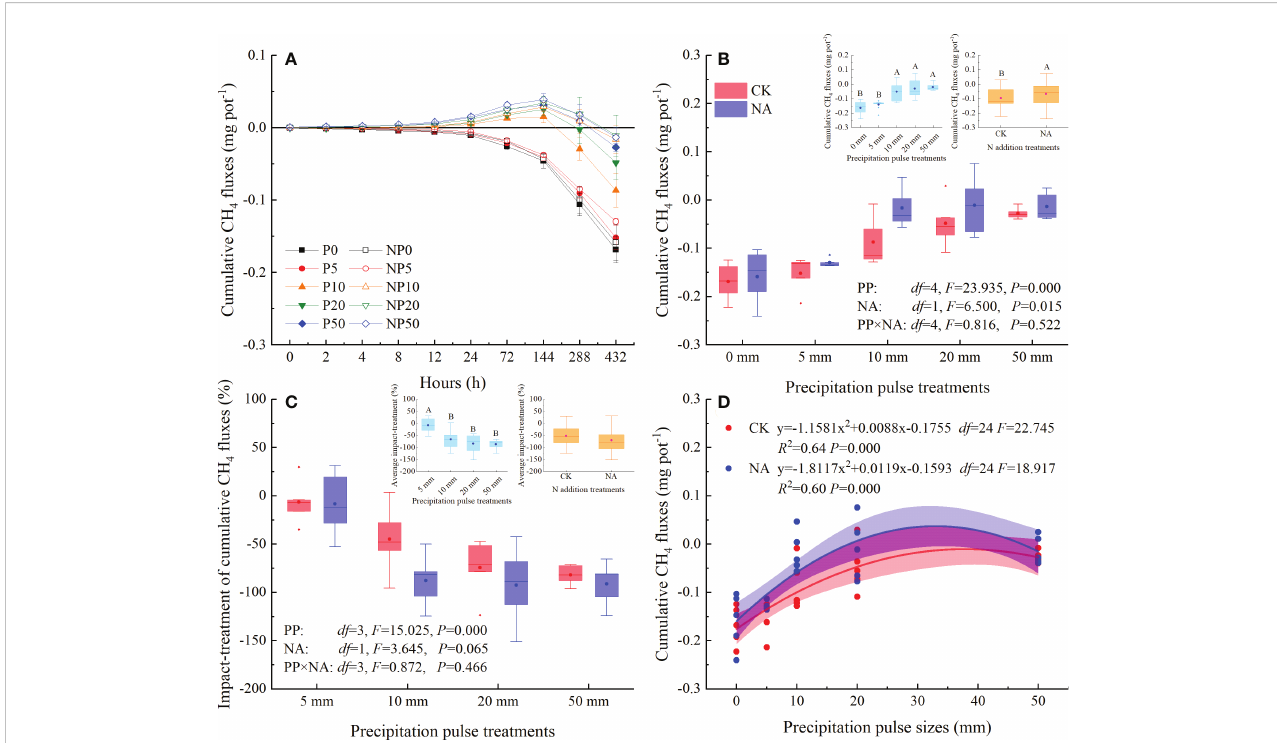
FIGURE 5 Responses of the cumulative CH 4 fl uxes ( (A) : temporal dynamic; (B) : average cumulative fl uxes; (C) : impact-treatment of cumulative CH 4 fl ux) to precipitation pulses and N addition, and the relationship between cumulative CH 4 fl uxes and precipitation pulse sizes (D) . The inserted graphs (light blue column) in panels B, C show the differences in cumulative CH 4 fl uxes and impact-treatment of cumulative CH 4 fl ux among the precipitation pulses. The inserted graph (orange column) in panel B shows the differences in cumulative CH 4 fl uxes between the control and N addition treatments. Boxplots show the median (lines within the box) and interquartile range (box boundaries). Whiskers extend to the most extreme data point within 1.5 × (75-25%) data range. The solid point represents the mean value. Different capital letters (above each boxplot) denote signi fi cant differences among the precipitation pulses or between the control and N addition